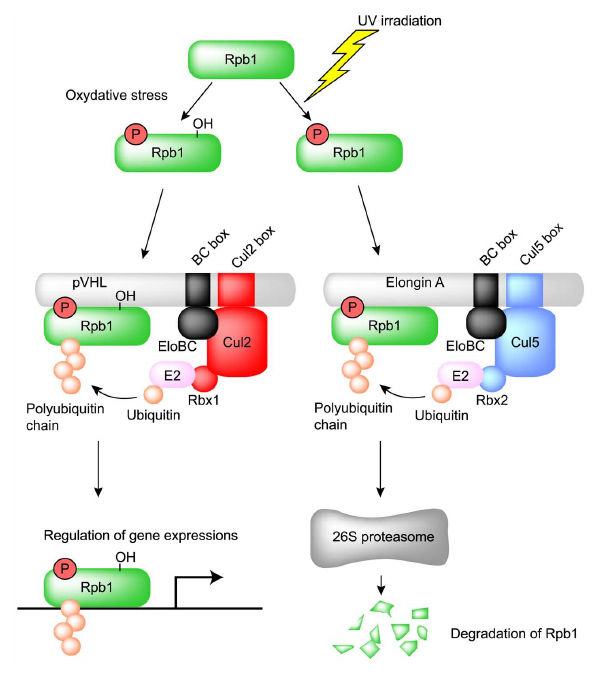
FIGURE 4 | Regulation of the large subunit of RNA polymerase II (Rpb1) by pVHL and ElonginA. Ser5 and Pro1465 of Rpb1 are phosphorylated and hydroxylated, respectively, by oxidative stress and then recognized by the Cul2-type ubiquitin ligase pVHL.The resulting polyubiquitinated Rpb1 is not degraded by proteasome and contributes to tumor growth by modulating gene expression in renal clear cell carcinoma. Ser5 of Rpb1 is also phosphorylated by UV irradiation and recognized by the Cul5-type ubiquitin ligase Elongin A for proteasomal